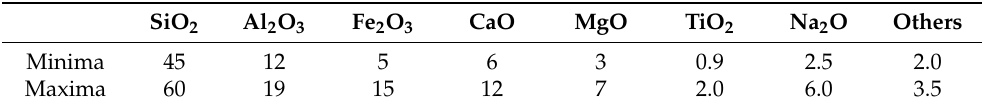
Table 1. Chemical composition of basalt fibres as declared by the manufacturer—percentage of overall mass [%]. SiO 2 Al 2 O 3 Fe 2 O 3 CaO MgO